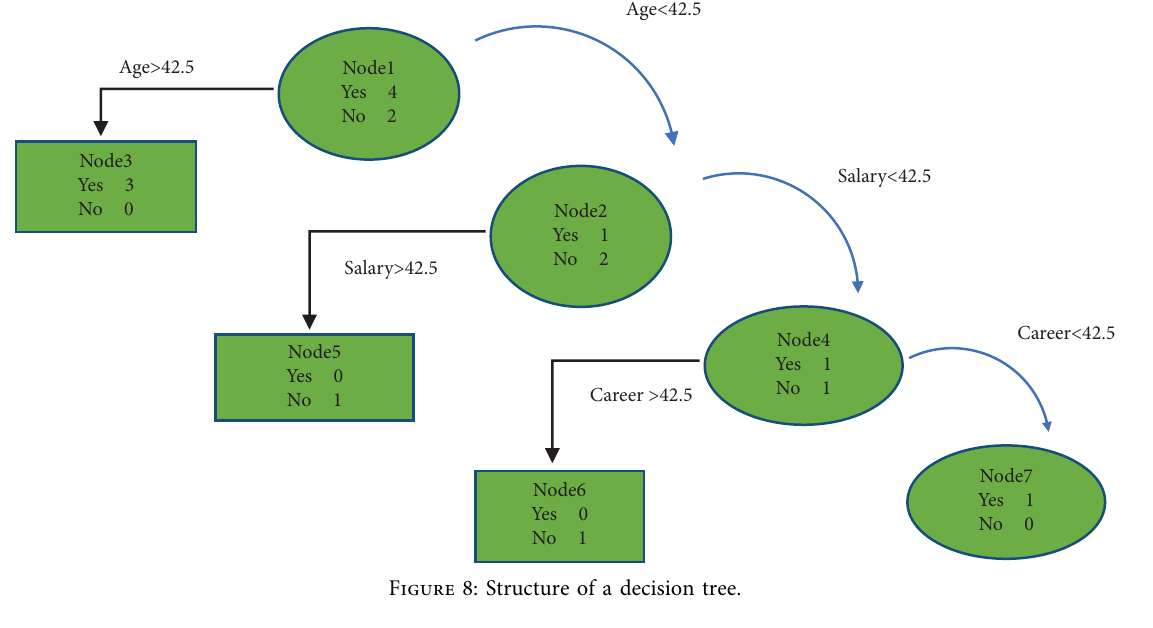
Figure 8: Structure of a decision